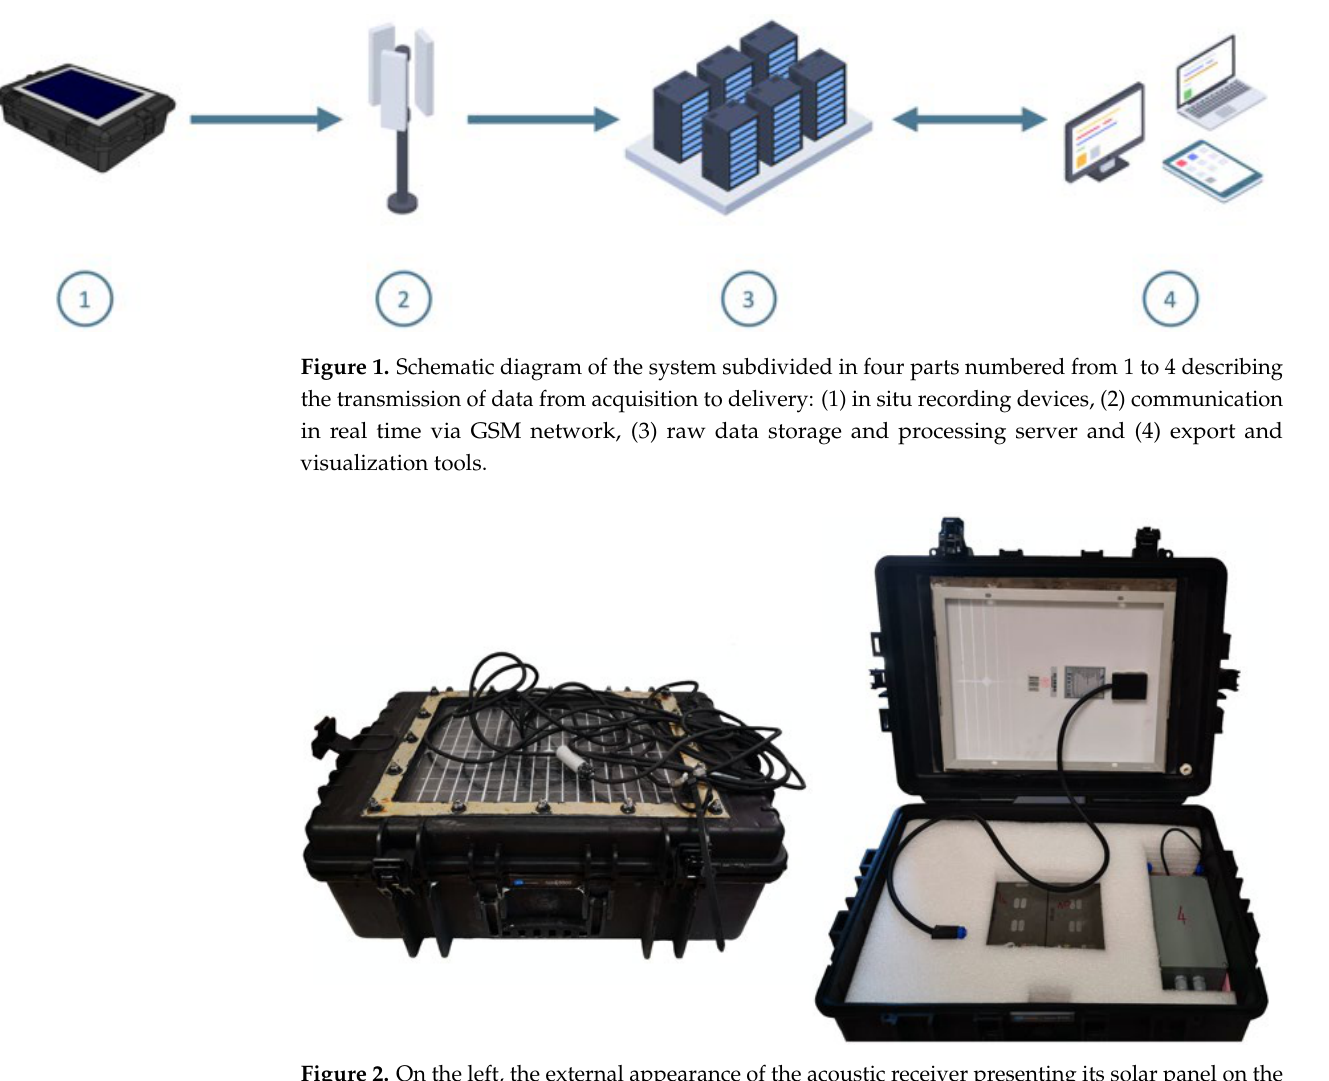
Figure 2. On the left, the external appearance of the acoustic receiver presenting its solar panel on the upper side. This case was chosen for its practicality, weight and shape for easy storage and handling before, during and after the experiments. On the right, the internal appearance of the acoustic receiver showing the electronic board enclosed in its waterproof case and the two batteries. Each component is enclosed in a polystyrene panel to prevent damage in rough sea conditions.